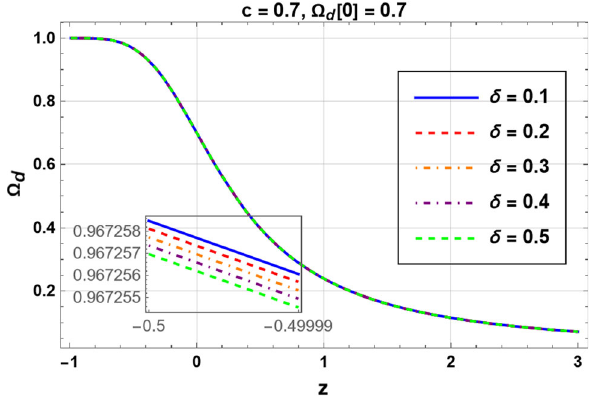
Fig. 5 The deceleration parameter q with δ = 0 . 2 and c = 0 . 8 to 1 . 2 is plotted w.r.t. redshift z by considering (cid:6) d [ z = 0 ] ≈ 0 . 7 , M 2 p = 1